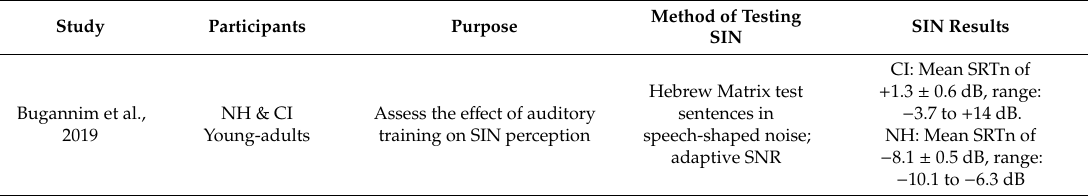
Table A1. Studies from the past two decades that tested speech-in-noise (SIN) recognition in cochlear implant (CI) users with prelingual